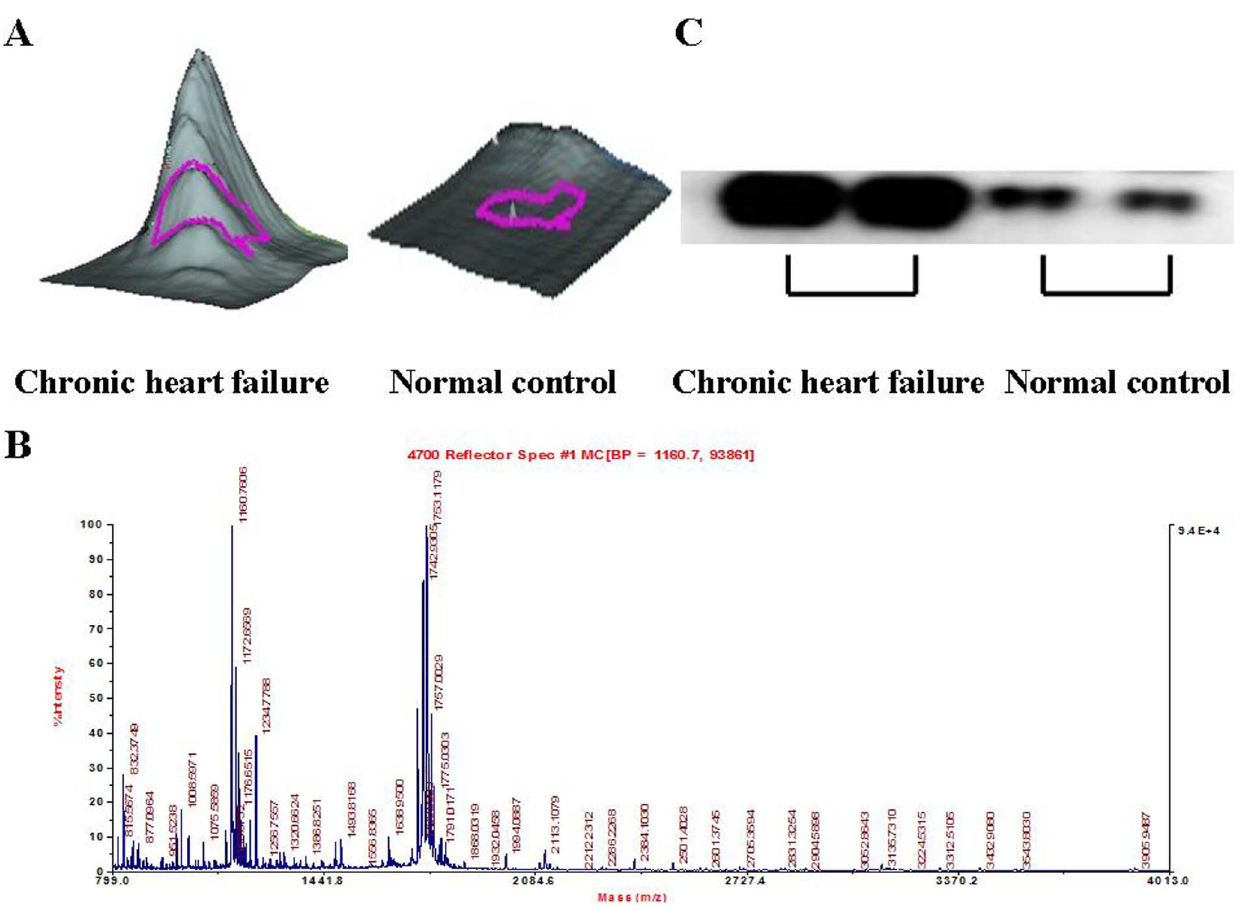
Figure 3. Verification of ORM1 protein expression in urine samples form patients with CHF and normal controls. (A) A 3-D view of ORM1 protein was to show the higher expression of ORM1 protein in urine of patients with CHF compared with normal controls. (B) Verification of ORM1 expression in individual urine samples of patients with CHF and normal controls by western blotting. (C) MS of in-gel trypsin digests of the protein and analysis of the depicted peptide spectrum resulted in the identification of ORM1.